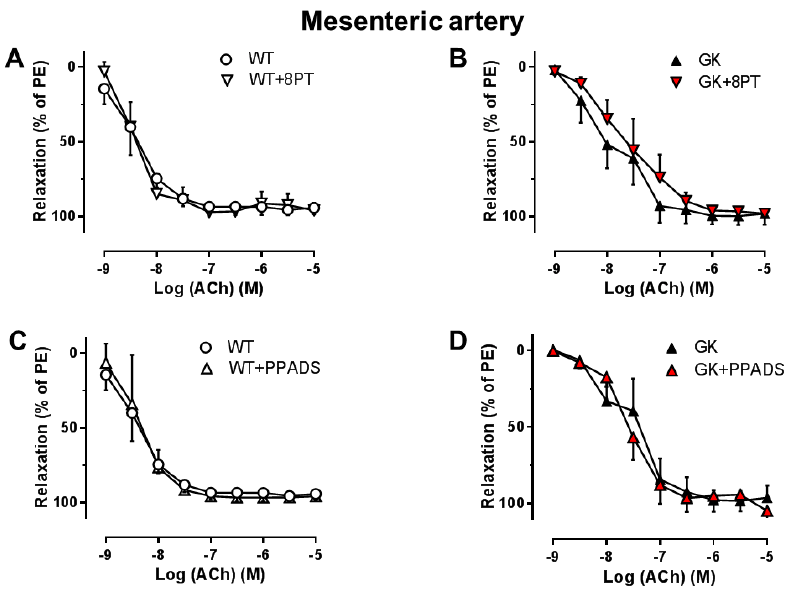
Figure 3. Effects of P1R and P2R antagonists on EDR in mesenteric arteries from WT and GK rats. Concentration-response curves for acetylcholine (ACh) in mesenteric arteries preconstricted with PE in the absence and presence of the non-selective P1R antagonist (8PT, 10 − 5 M) from WT ( A , n = 3) or GK ( B , n = 4). Concentration-response curves for ACh in mesenteric arteries preconstricted with PE in the absence and presence of the non-selective P2R antagonist (PPADS, 10 − 5 M) from WT ( C , n = 3) or GK ( D , n = 4). Data are presented as mean ± SEM as percentage relaxation of PE. No significant differences were detected with two-way ANOVA.